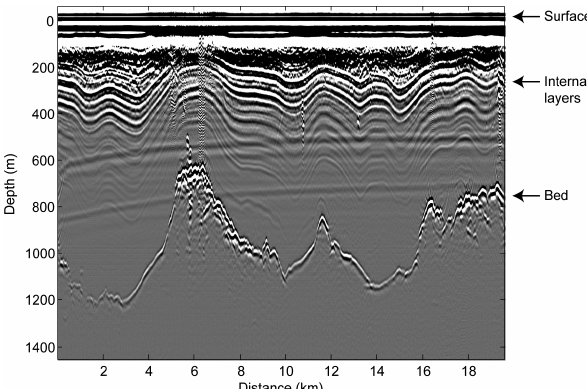
Figure 2. An example of a processed radar image of the UU data set, going from north to south. The location of the profile is marked in Fig. 1. Various features are indicated in the image, including in- ternal layers, the bed reflector with high subglacial peaks and the surface